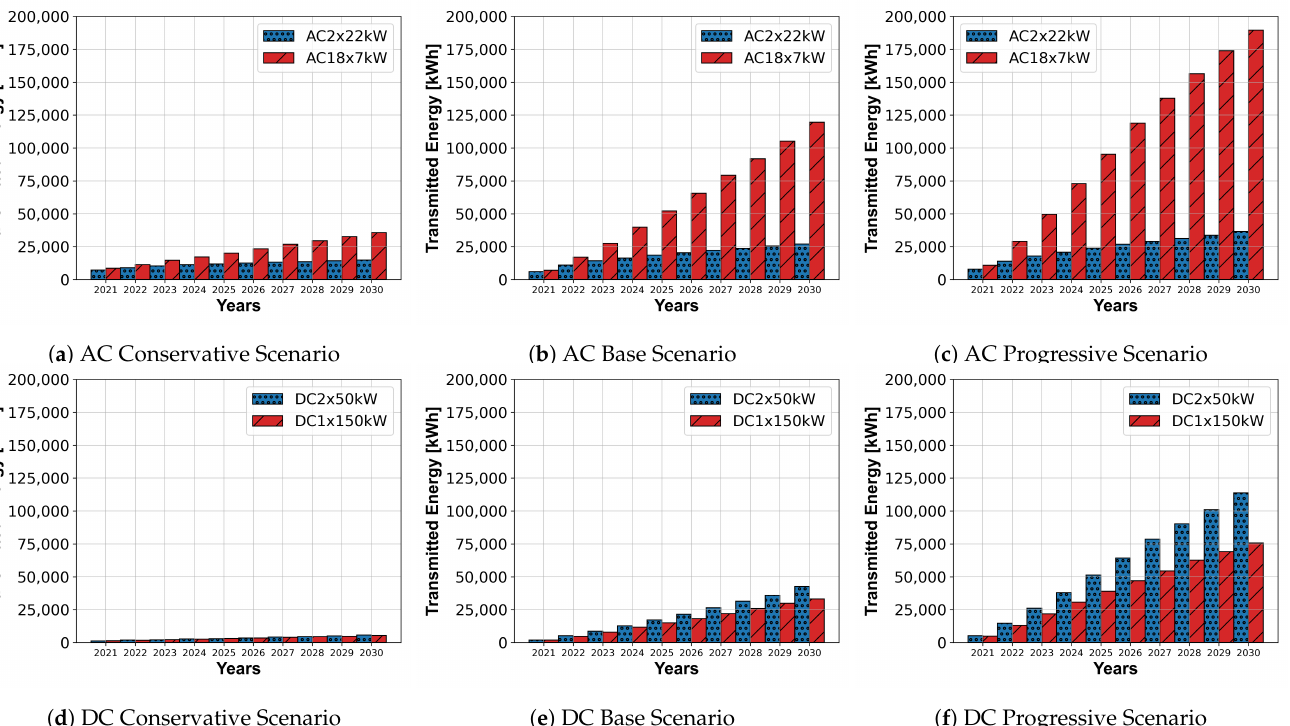
Figure 12. Transmitted energy for the investigated charging